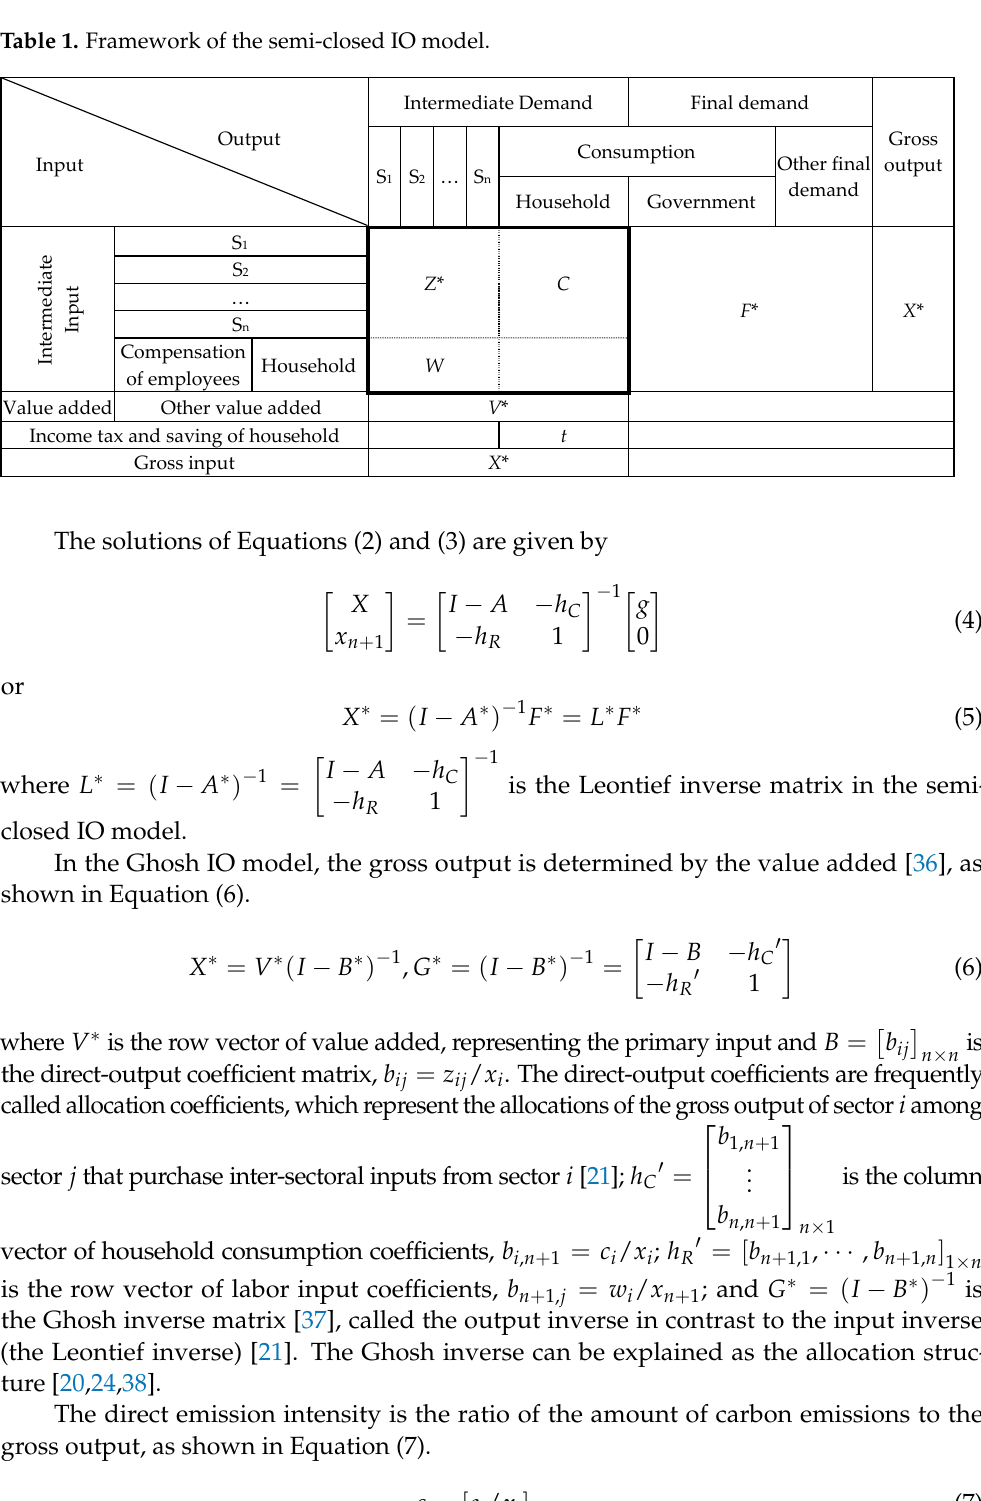
  . Table 1 shows the